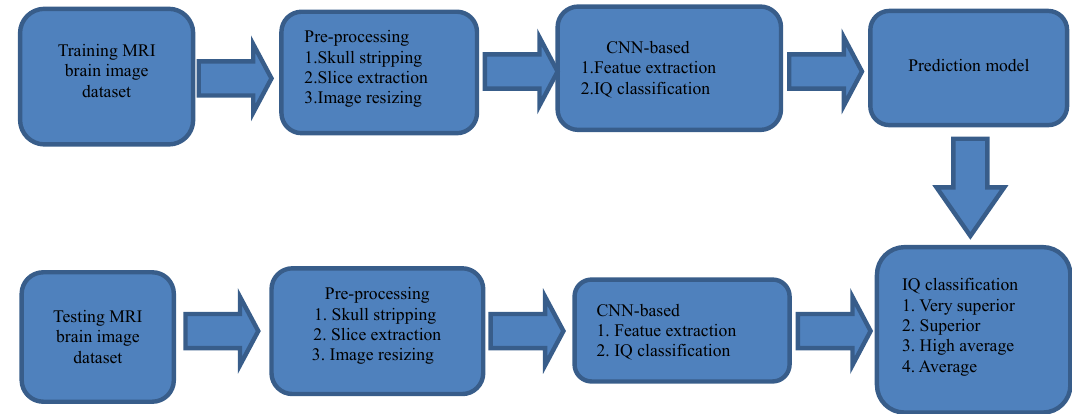
Fig. 1 Proposed IQ classification system [21]